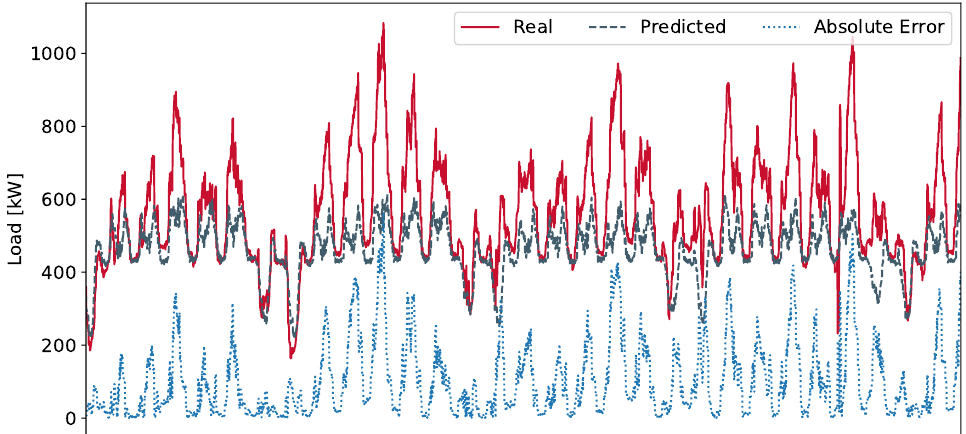
Figure 6. Real and predicted November load and the corresponding absolute error.